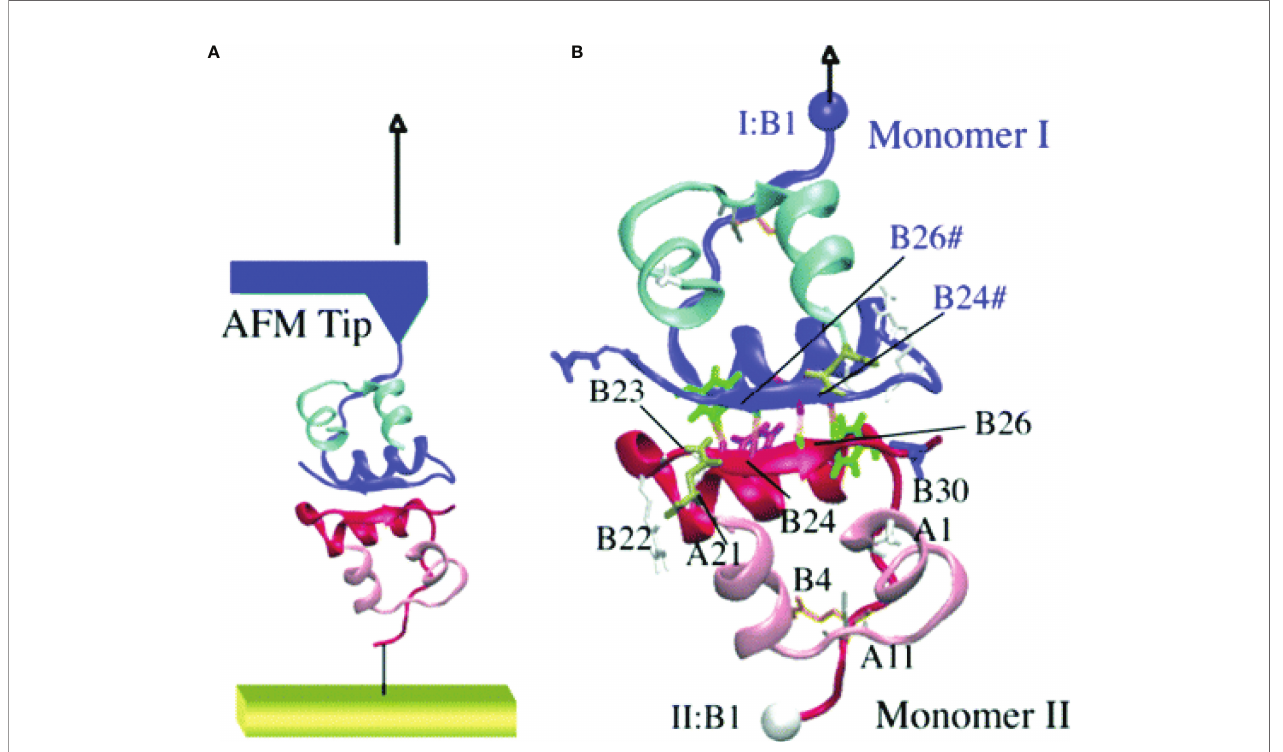
FIGURE 4 | Steered molecular dynamics (SMD) simulations of the insulin dimer. (A) A schematic model of the AFM experiment with the insulin dimer as the target protein. (B) The C a atom of PheB1 of monomer I (top) is pulled after attaching a harmonic spring potential, while the C a atom of PheB1 of monomer II (bottom) was held fi xed. The residues involved in monomer-monomer interactions are labeled. Reprinted with permission from Kim et al. (81), Copyright 2006 American Chemical